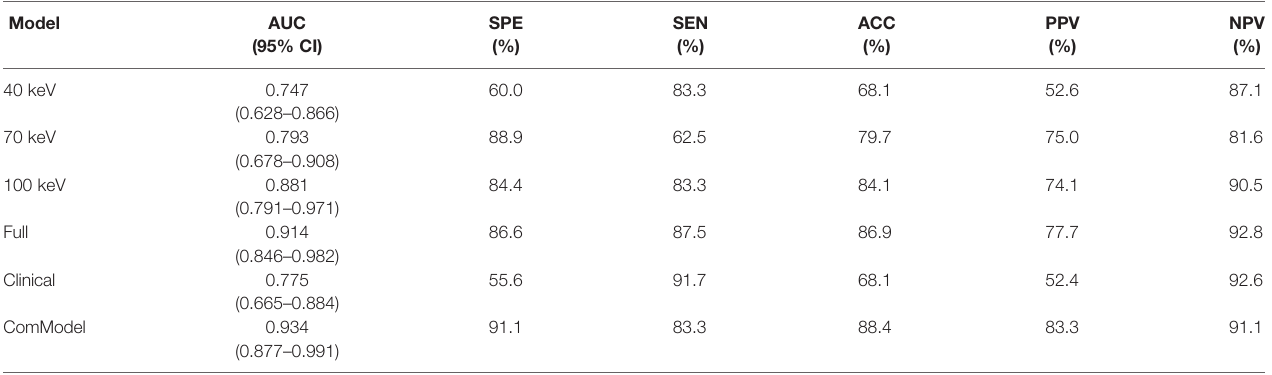
TABLE 3 | Radiomics, clinical-only, and clinical-radiomics model predictive performance. Model